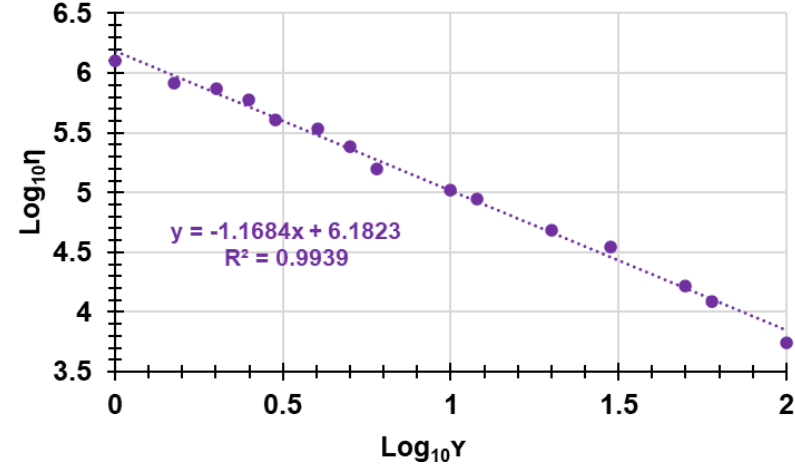
Figure 13. Cross rheological model. Table 6. Equation, correlation coefficient (R 2 ), slope, and intercept values of the linear regressions obtained by fitting the rheogram data to the Cross mathematical